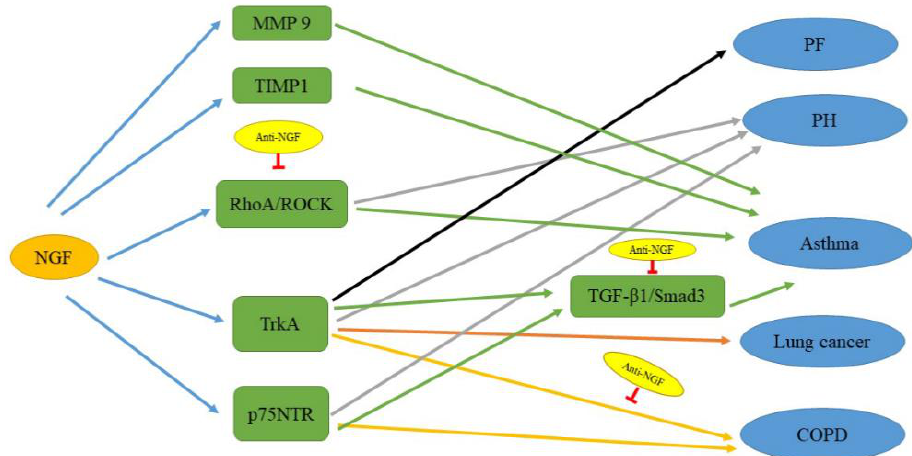
Figure 3. The signaling pathways related to NGF in lung diseases. NGF upregulates these factors to cause the development of lung diseases. Anti-NGF, which regulates the RhoA–ROCK, TGF- β1–SMAD3, and NGF–TrkA pathways, can improve those lung diseases. The black line indicates the pathway affecting PF; the gray lines indicate pathways affecting PH; the green lines indicate pathways affecting asthma; the orange lines indicate pathways affecting lung cancer; and the yellow lines indicate pathways affecting COPD.